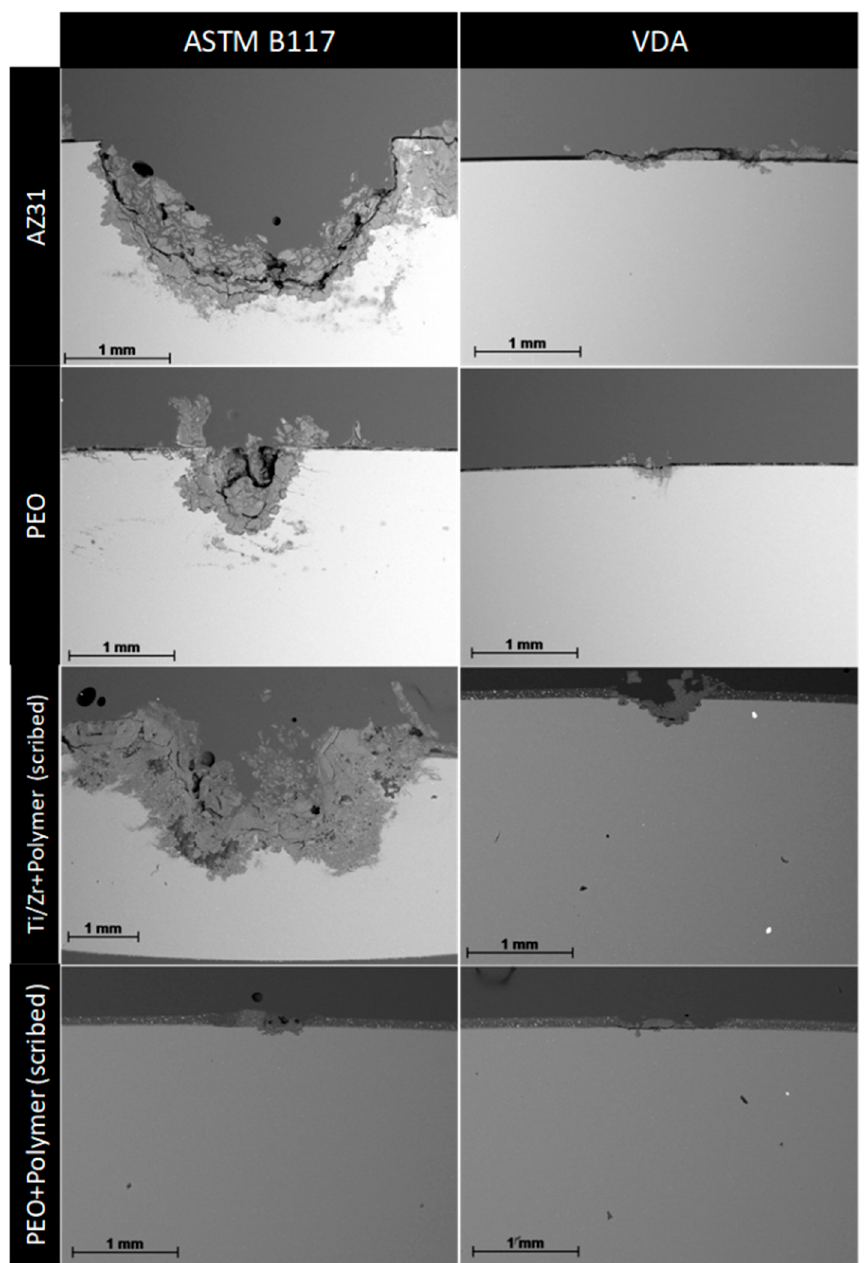
Figure 22. BSE cross-sections of AZ31 specimens after exposure to ASTM B117 and VDA tests [63]. Reprinted from [63] with permission from Elsevier.